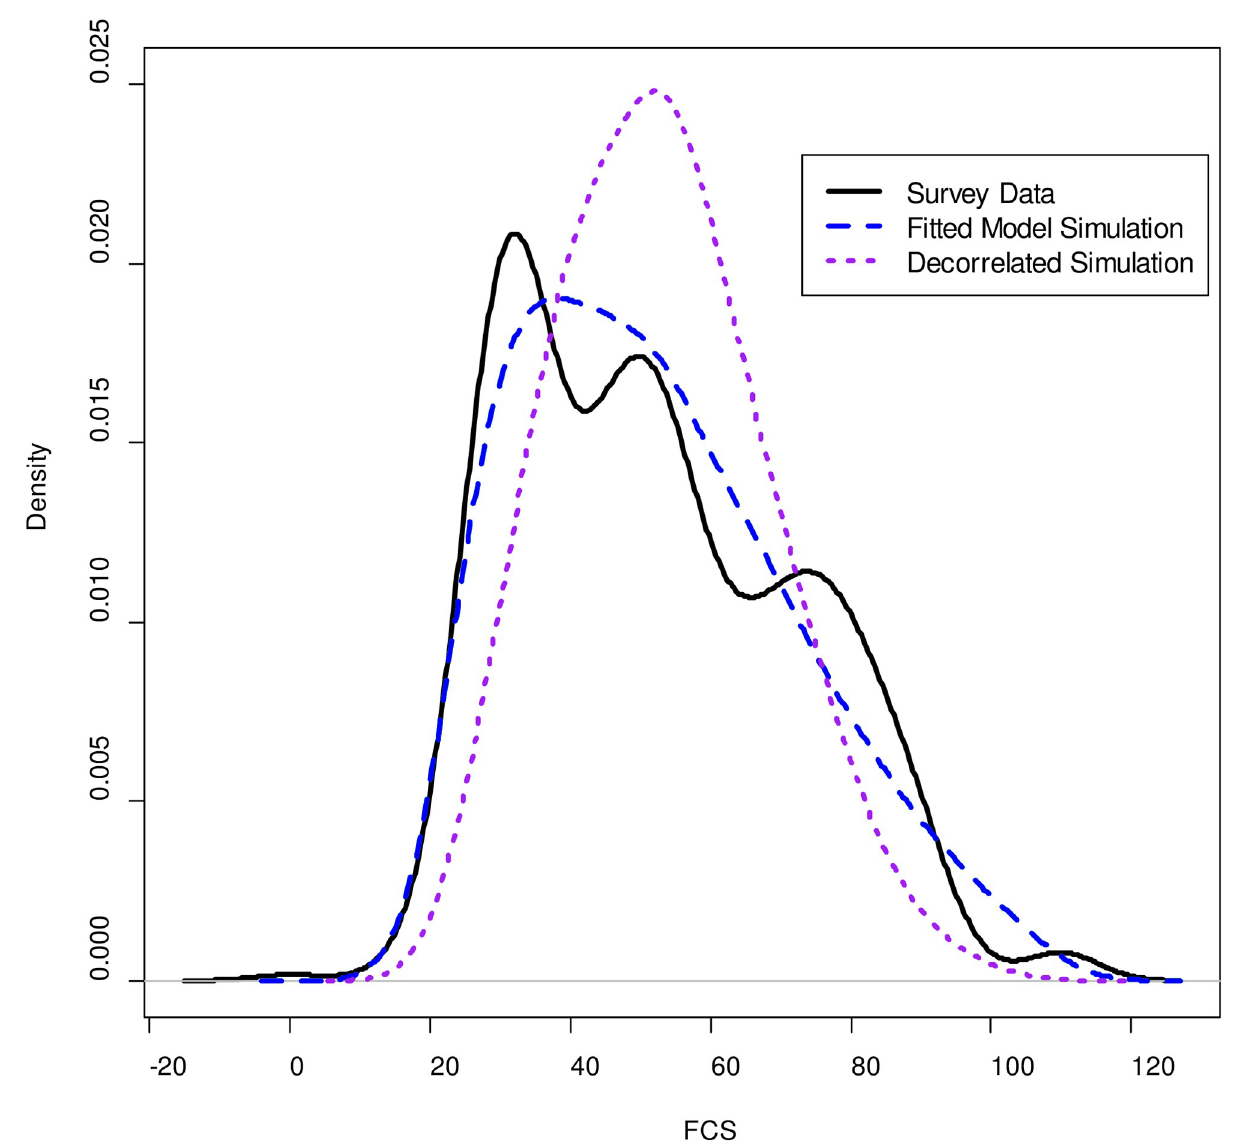
Fig 2. Comparison of beta-binomial and decorrelated model fits to survey data in the Al Jawf governorate.